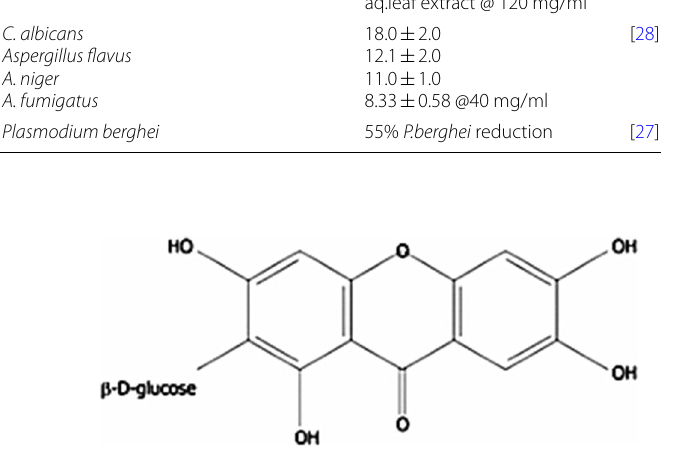
Fig. 2 Chemical structure of mangiferin. Source: